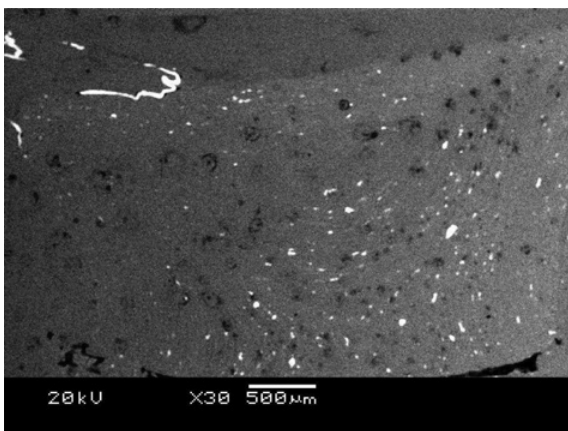
Figure 7: SEM backscattered electron image of copper particles incorporated in the nugget